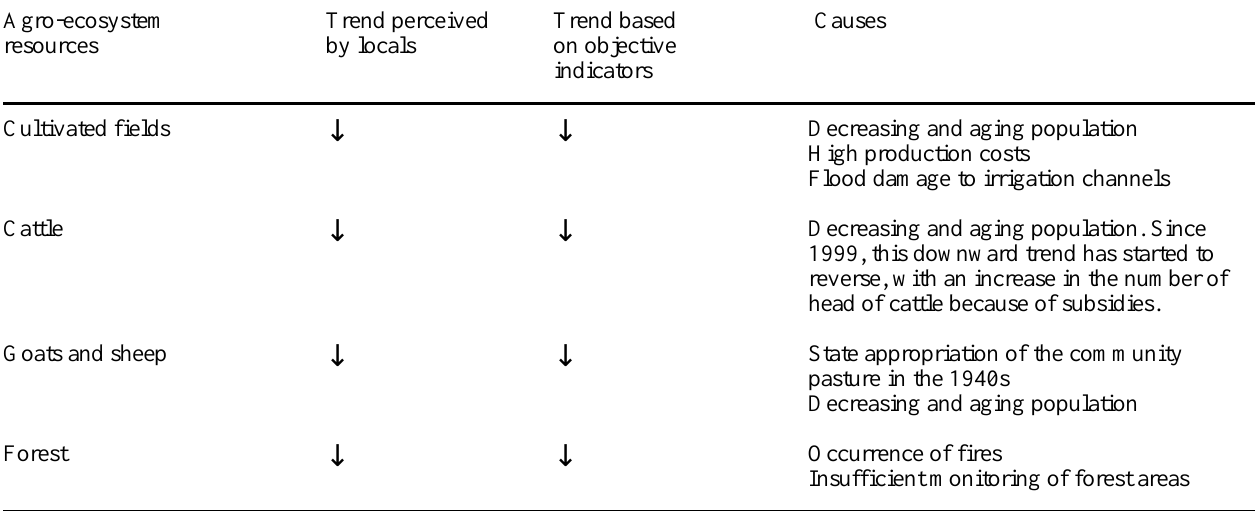
Table 3 . Trends in agro-ecosystem resources identified in the semistructured interviews and by means of inventories and other surveys, and the main causes of those trends according to the semistructured interviews and trend lines exercises.